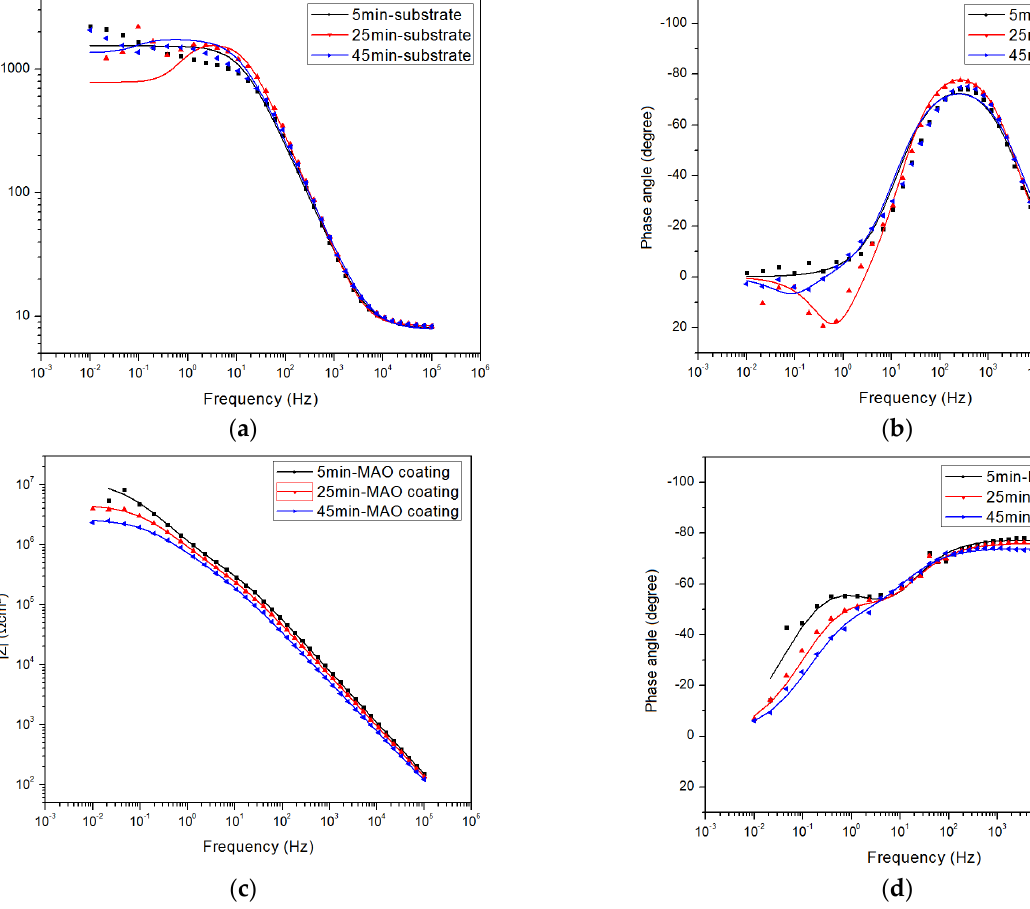
Figure 5. EIS measurements (scattered points) and fitting results (solid lines) of the as-received alloy and the MAO-coated alloy at different immersion times at OCP. ( a , c ) Bode plots of impedance vs. frequency and ( b , d ) bode plots of phase angle vs. frequency.